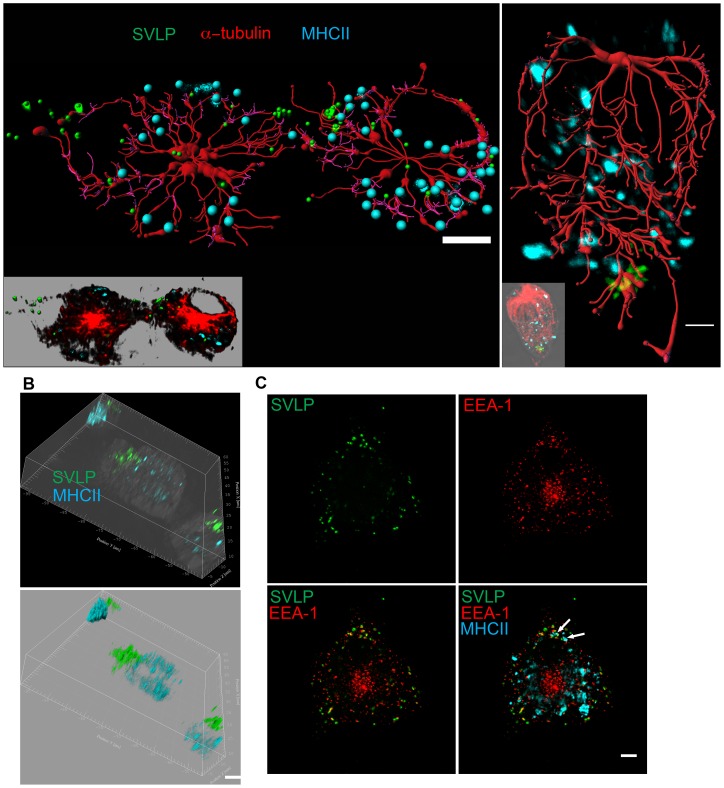
SVLP association with DC microtubules, leading edge and MHCII.(A) Pre-chilled DC were incubated with 2.5 µg/ml SVLP for 20 min on ice, followed by shifting to 39°C for 10 min. Samples were then fixed, permeabilised and labelled with antibody targeting α-tubulin (red) and MHCII (blue). Acquisition was by confocal microscopy; high-resolution stacks were prepared and analysed using Filament Tracer and Spots modules in IMARIS. Visualisation was enhanced using filament tracer (microtubules) and spot (SVLP, MHCII) modules. Scale bars: 5 µm (left), 2 µm (right). (B) Pre-chilled DC were incubated with 2.5 µg/ml SVLP for 30 min on ice, followed by washing and shifting to 39°C for 20 min. Cells were then fixed, permeabilised and labelled with antibody targeting MHCII (blue). Acquisition was by confocal microscopy; high-resolution stacks were prepared using IMARIS. Scale bar: 5 µm. (C) The same cultures were used as in (B), but incubated for 2 hours. Cells were then fixed, permeabilised and labelled with antibody targeting EEA-1 (red) or MHCII (blue). The arrows indicate sites of potential SVLP and MHCII association. Acquisition was by confocal microscopy; high-resolution stacks were prepared using IMARIS. The arrow shows a vesicle in which SVLP and MHCII were present. Scale bar: 5 µm.